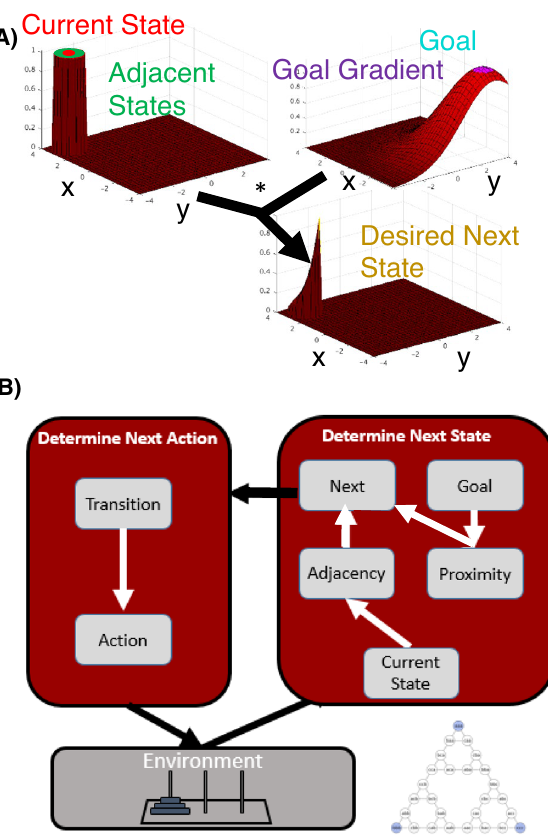
Figure 1. ( A ) The GOLSA model determines the next desired state by hill climbing. Each layer represents the same set of states, one per neuron. The x- and y-axes of the grids represent abstracted coordinates in a space of states. Neurons are connected to each other for states that are reachable from another by one action, in this case neighbors in the x,y plane. The Goal state is activated and spreads activation through a Goal Gradient (Proximity) layer, thus dynamically specifying the value of each state given the goal, so that value is greater for states nearer the goal state. The Current State representation activates all Adjacent States, i.e. that can be achieved with one state transition. These adjacent states mask the Goal Gradient input to the Desired Next State, so that the most active unit in the Desired Next State represents a state attainable with one state transition and which will bring the state most directly toward the goal state. The black arrows indicate that the Desired Next State unit activities are the element-wise products of the corresponding Adjacent States and Goal Gradient unit activities. The font colors match the model layer to corresponding brain regions in Figs. 3 and 4. ( B ) The desired state transition is determined by the conjunction of current state and desired next state. The GOLSA model learns a mapping from desired state transitions to the actions that cause those transitions. After training, the model can generate novel action sequences to achieve arbitrary goal states. Adapted from 34